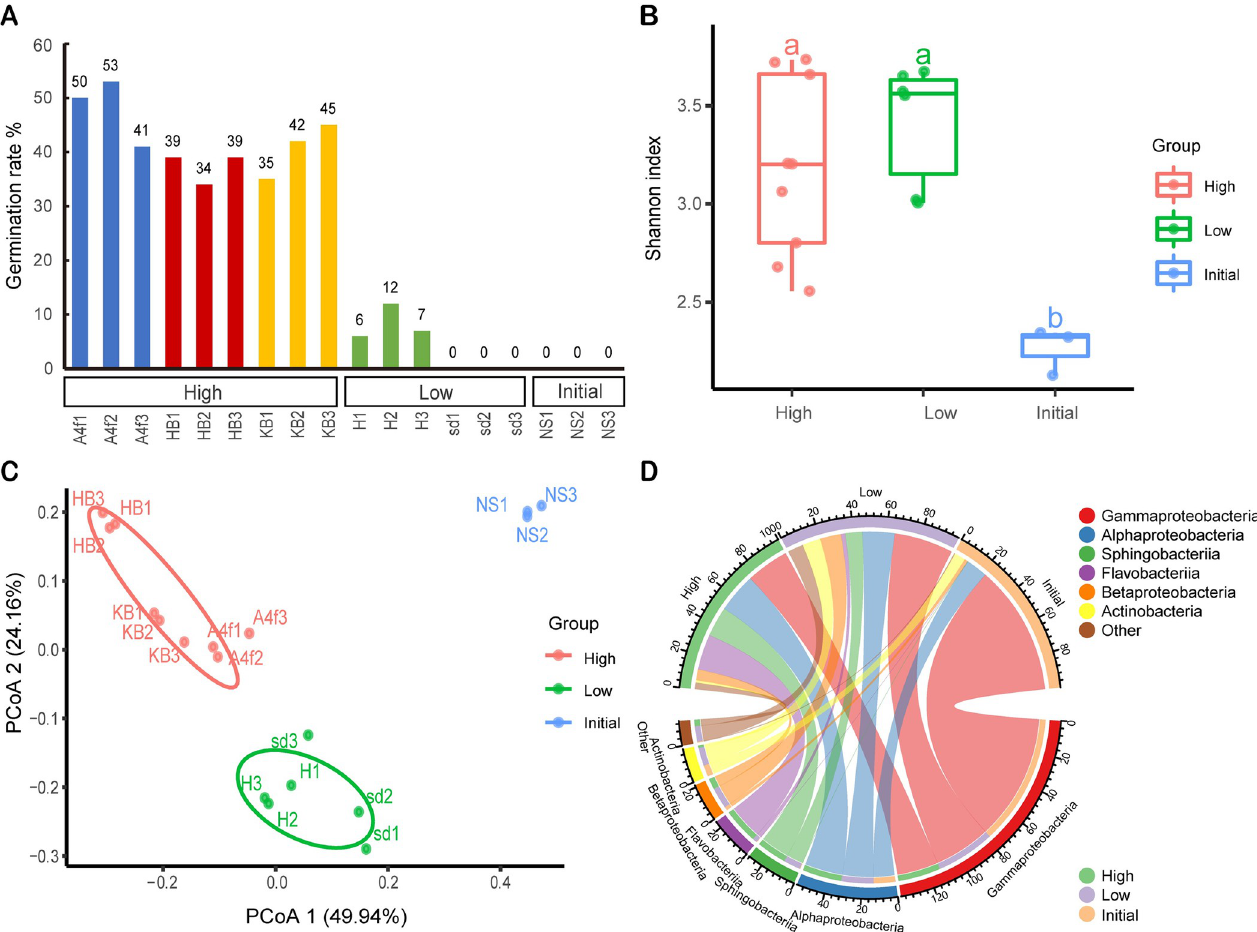
Fig 5. The shift of bacterial community composition after 7 days of incubation. Comparison of bacterial communities differently treated and inducing ‘high’ or ‘low’ germination rates of P . brassicae , in relation to the ‘initial’ untreated non-sterile resting spores. (A) Germination rate of resting spores of P . brassicae in each sample used for 16S rRNA gene amplicon sequencing. (B) Shannon index of the microbiota from ‘high’, ‘low’ and ‘initial’ groups. (C) Principal coordinate analysis (PCoA) based on the Unifrac distance showing that the bacteria of ‘high’ germination rate group separate from those of ‘low’ germination and the initial groups ( P < 0.001, PERMANOVA by Adonis). (D) Chord diagram visualizing community structure in different groups at class- level. HB: B . subtilis cell suspension with 1/10 strength Hoagland solution; KB: B . subtilis cell suspension with 6 mM potassium nitrate; A4f: filtrate of bacterial strain A4 with 1/10 strength Hoagland solution; sd: sterilized deionized water; H: 1/10 strength Hoagland solution; NS: non-sterile resting spore suspension (initial bacterial community).